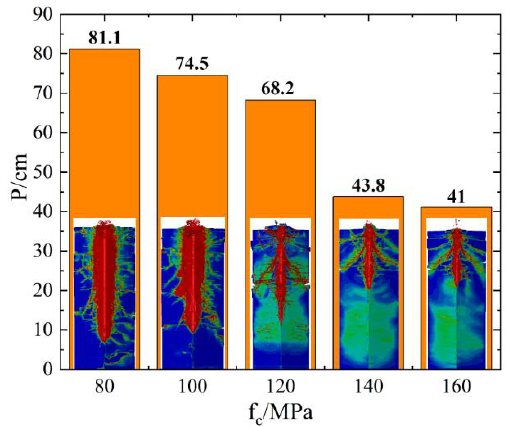
Figure 15. Relation between penetration depth and target strength.